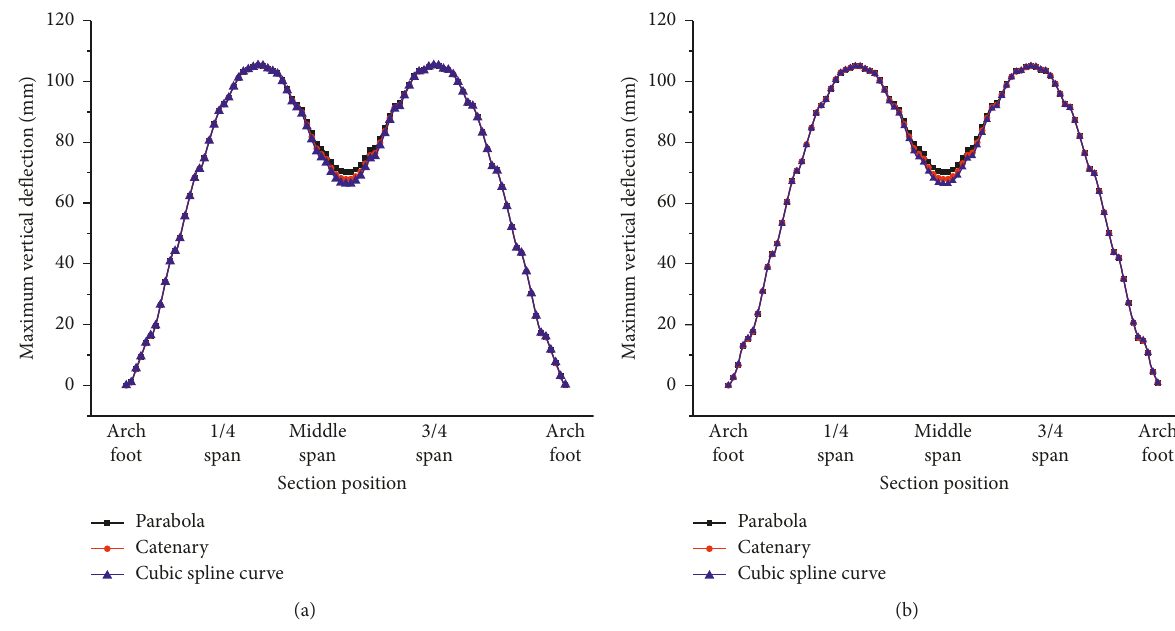
Figure 12: Deflection distribution of the main arch rib. (a) Deflection distribution of the upper chord. (b) Deflection distribution of the lower